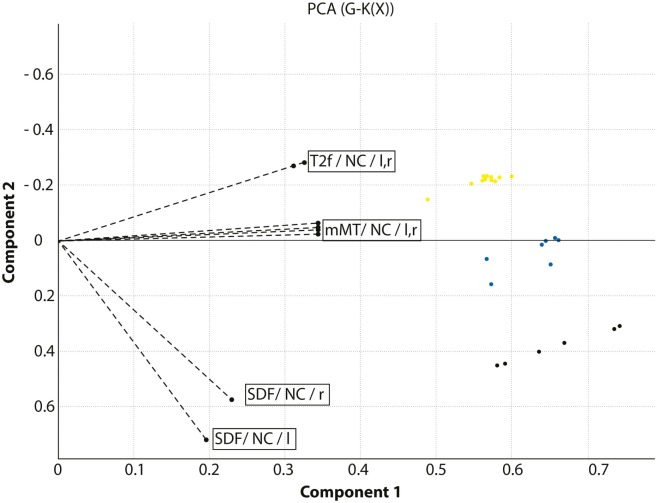
Combined presentation of the factor loadings and the classification of the cohort under investigation. The axes indicate the main components of the principal component analysis. The dotted lines indicate the relative contribution of the model-based magnetization transfer (mMT) parameters T2f, SDf, kf, kr, and T2r extracted from the caudate nucleus (NC) in the left and right hemisphere to the segregation between HC, Huntington’s disease (HD) carriers and manifest HD patients. HD patients are displayed in yellow, HD carriers in blue, and healthy controls in black.